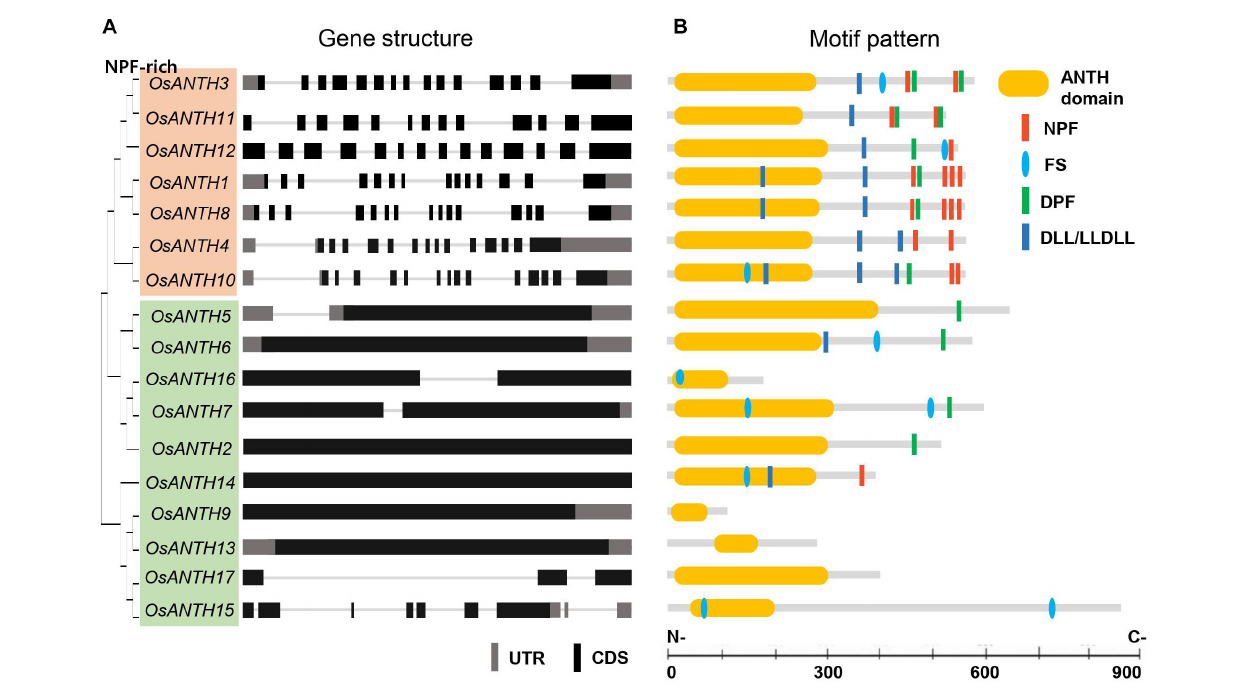
FIGURE 1 | Gene structure and motif pattern of rice AP180 N-terminal homology (ANTH) proteins. (A) Phylogenetic tree and gene structure of seventeen ANTH genes. Upper 7 and lower 10 ANTH proteins are divided into two subgroups according to gene structure (whether they contain no or only a few introns or many introns). Black and gray boxes indicate coding sequences (CDSs) and untranslated regions (UTR), respectively, and lines represent introns. (B) Motif analysis of ANTH proteins: ANTH, asparagine-proline-phenylalanine (NPF), the clathrin-binding motif aspartic acid-leucine-leucine/leucine-leucine-aspartic acid-leucine-leucine (DLL/LLDLL), the clathrin-binding motif phenylalanine-Serine (FS), and the α -adaptin-binding motif aspartic acid-proline-phenylalanine (DPF). Bar in each section represents 100